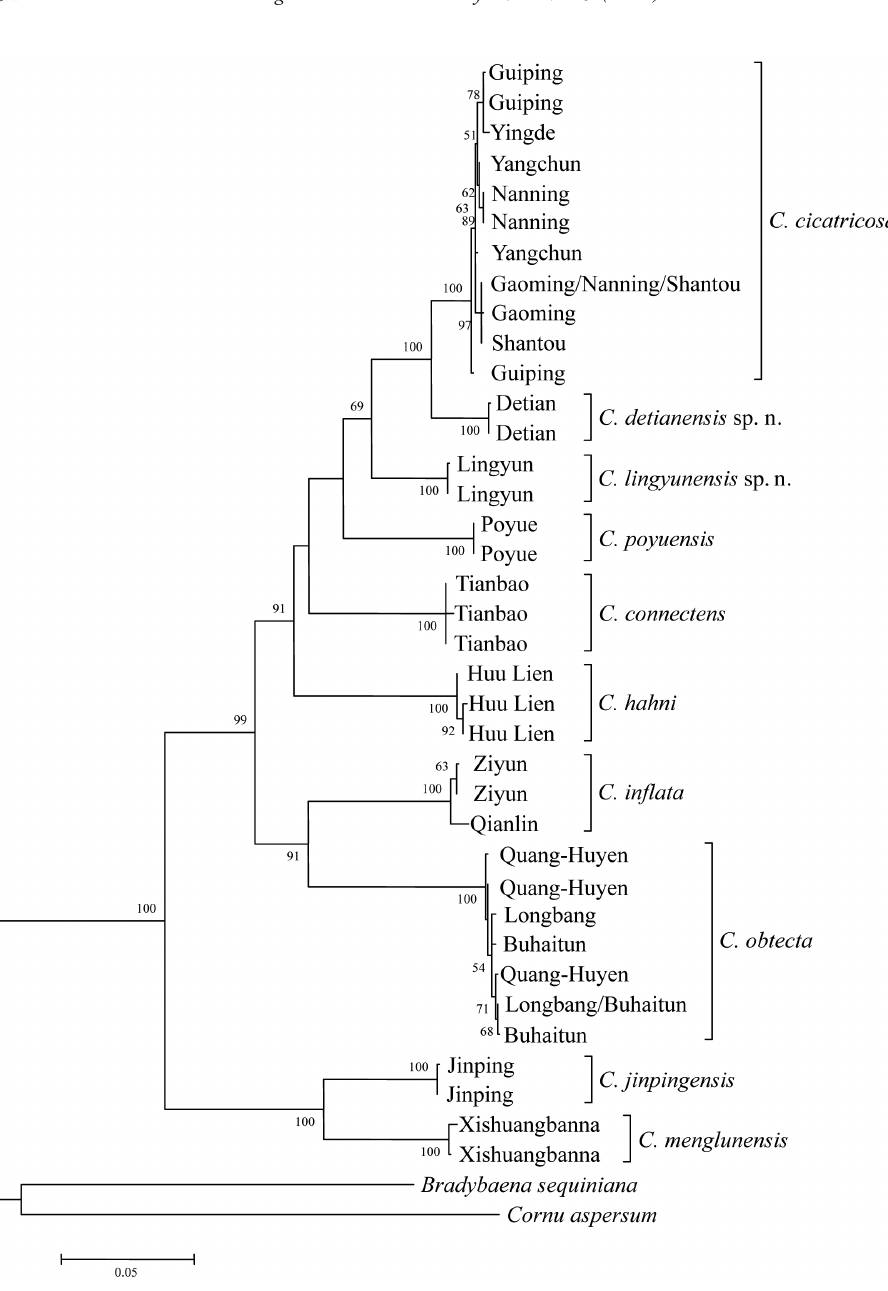
Figure 2. Maximum Likelihood tree based on analysis of the concatenated dataset of COI, 16S, and ITS2 sequences. Numbers beside nodes indicate bootstrapping support (%) for main